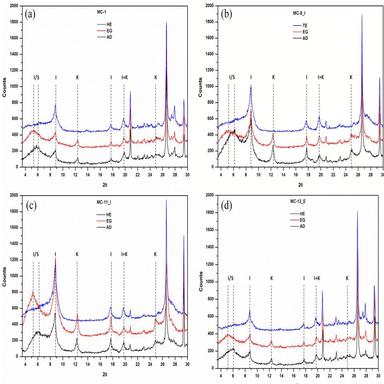
XRD patterns of selected oriented aggregates from samples MC-1 (a), MC-8_I (b), MC-11_I (c) and MC-13_E (d). (AD = Air dried, EG = ethylene-glycolated, HE = Heated).